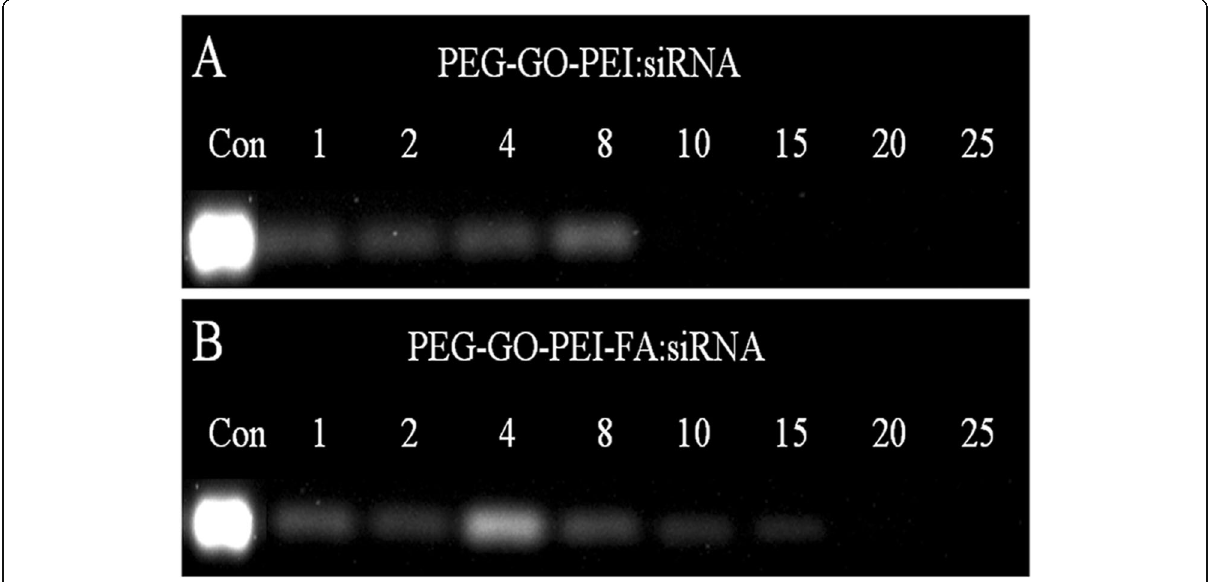
Fig. 3 The siRNA-loading capability at different weight ratios. Agarose gel retardation assay was conducted to evaluate the interaction between siRNA and nanocarrier. a PEG-GO-PEI and b PEG-GO-PEI-FA at the various weight ratios